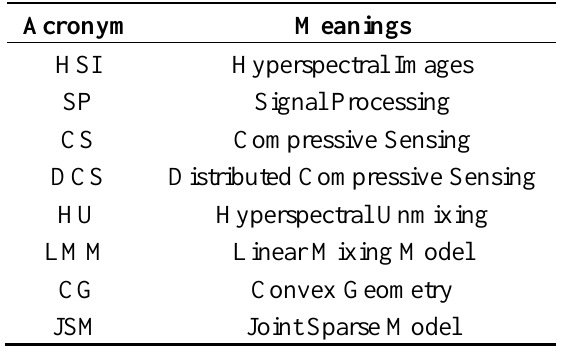
Table 1. Important acronyms used in this